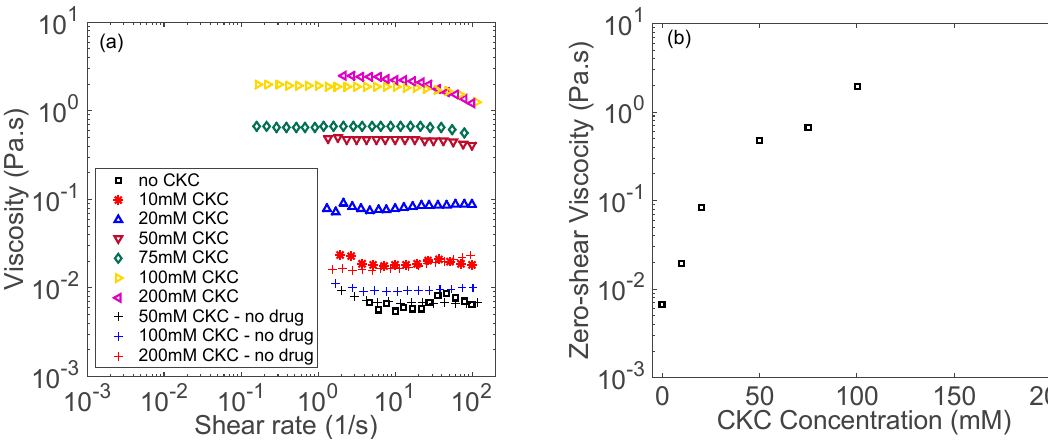
Figure 2. ( a ) Shear viscosity as a function of shear rate for aggregates made of cetalkonium chloride (CKC) and naproxen sodium (NPNa). ( b ) Zero-shear viscosity as a function of CKC concentration. Measurements were performed at room temperature and at a fixed concentration of naproxen sodium (30 mM) and Brij 97 (20 wt%).